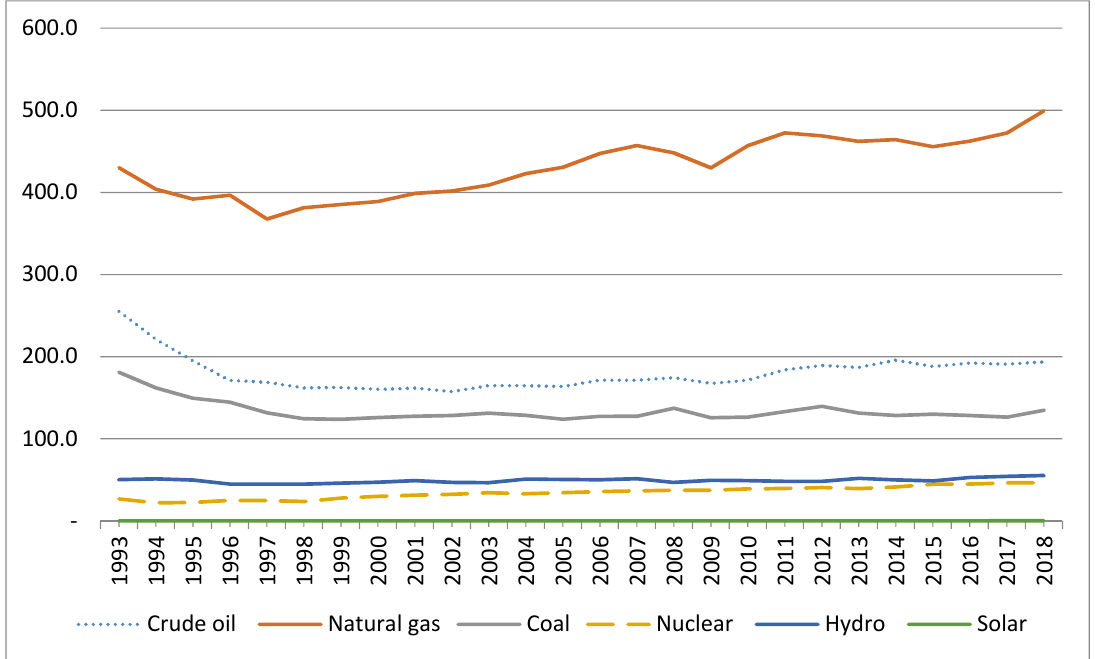
Figure 1. Energy consumption diversification (CIS region), 1993–2018, million tons of oil equivalent, 55 [4]. 56